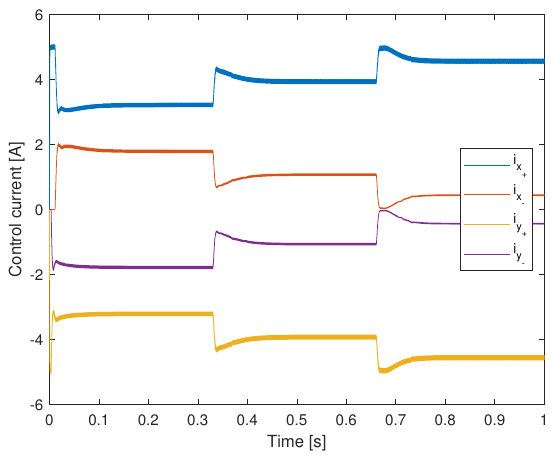
Figure 11. Phase currents with the star connection. The plots in Figures 12–14 allow a comparison of the displacements and the phase currents with another topology in which each phase is independently driven by an